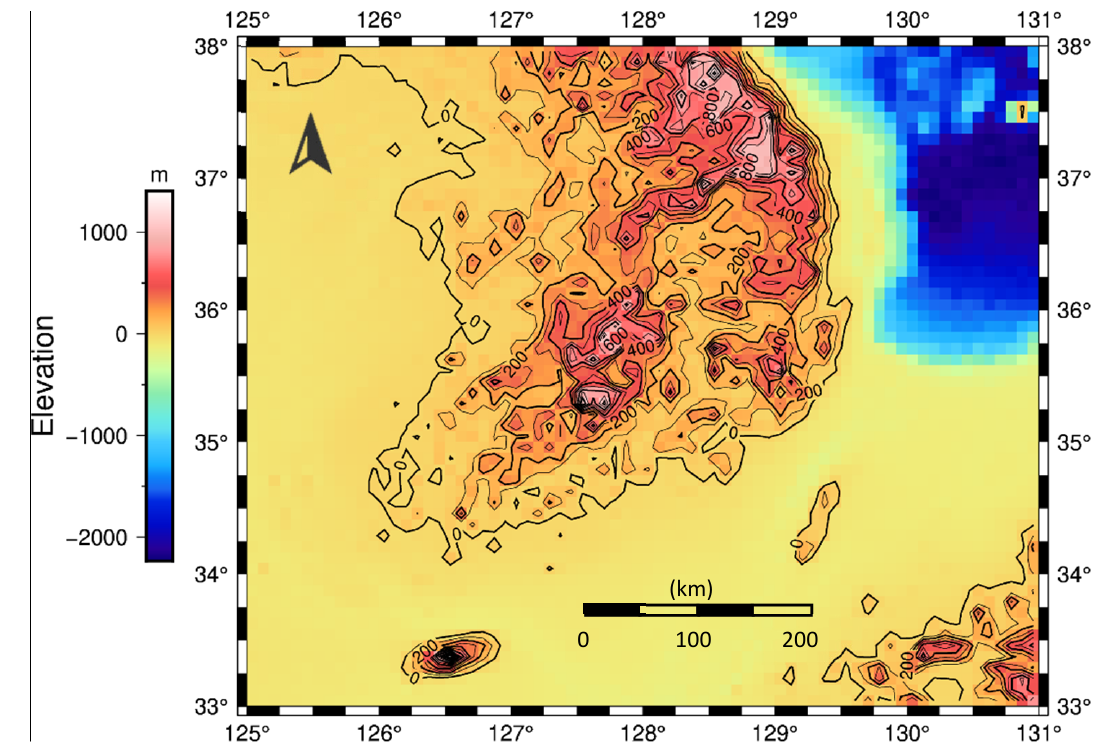
Figure 6. Southern portion of the Korean Peninsula and islands and their elevation (m). The coefficients are clustered into twelve groups. The largest group consists of 27 sites, which are located in southeastern coastal line of South Korea. The estimated trend coefficient of the group is about 0.47, such that the increasing trend of extreme rainfall is detected. The second largest group consists of 22 sites, which are located in the midland, and the estimates are about 0.16. From the obtained estimates, the trends in the west and the midland are much weaker than the ones in the south and east. In the western coastal site, the homogenous site is estimated, and relatively weak trend is detected.